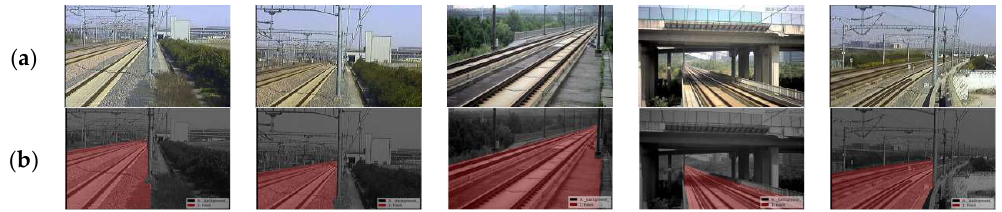
Figure 12. Samples in railway dataset. ( a ) Images from PTZ cameras under different conditions. ( b ) Ground truth of the track area.